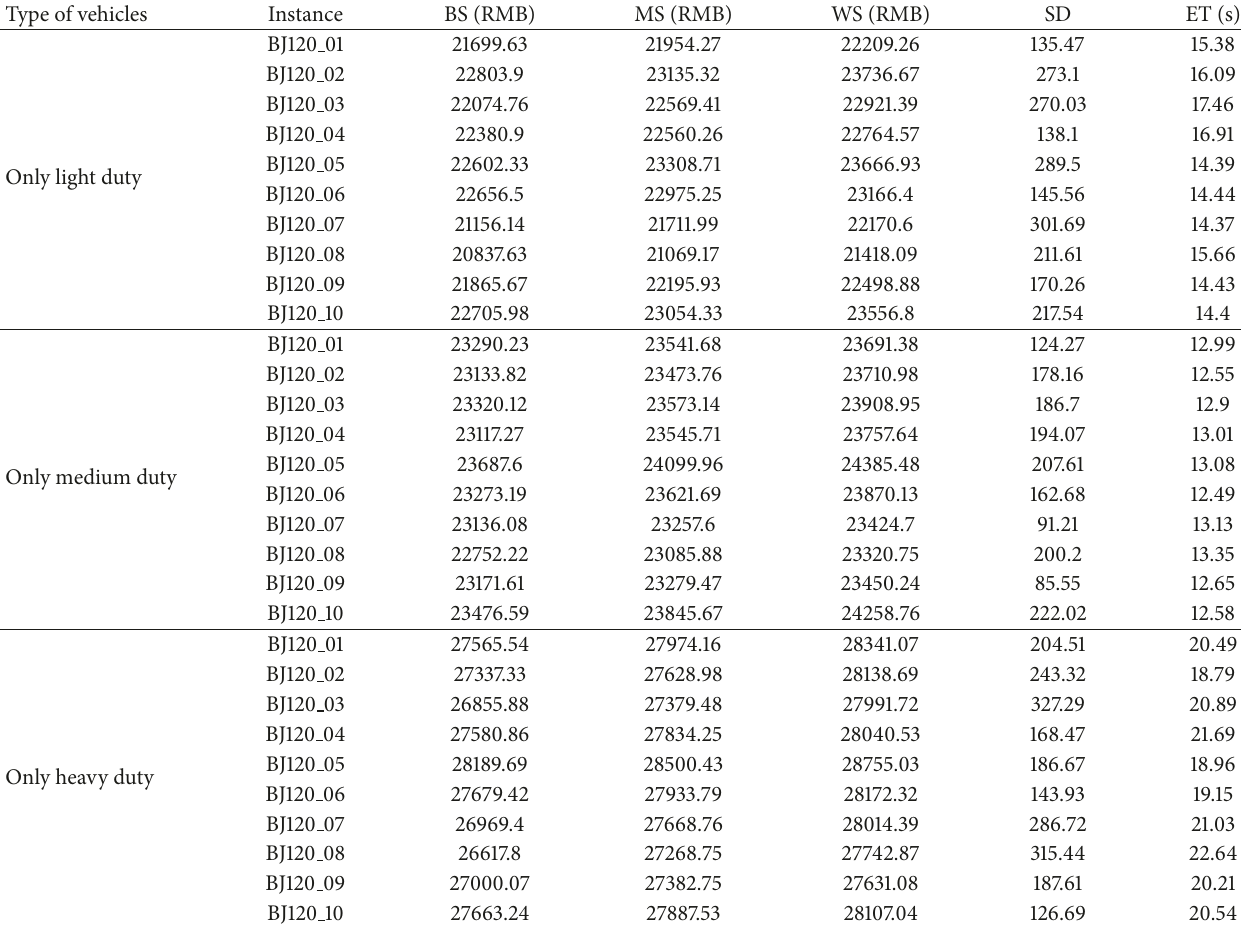
Table 12: Computational results on the 120-node instances by using different